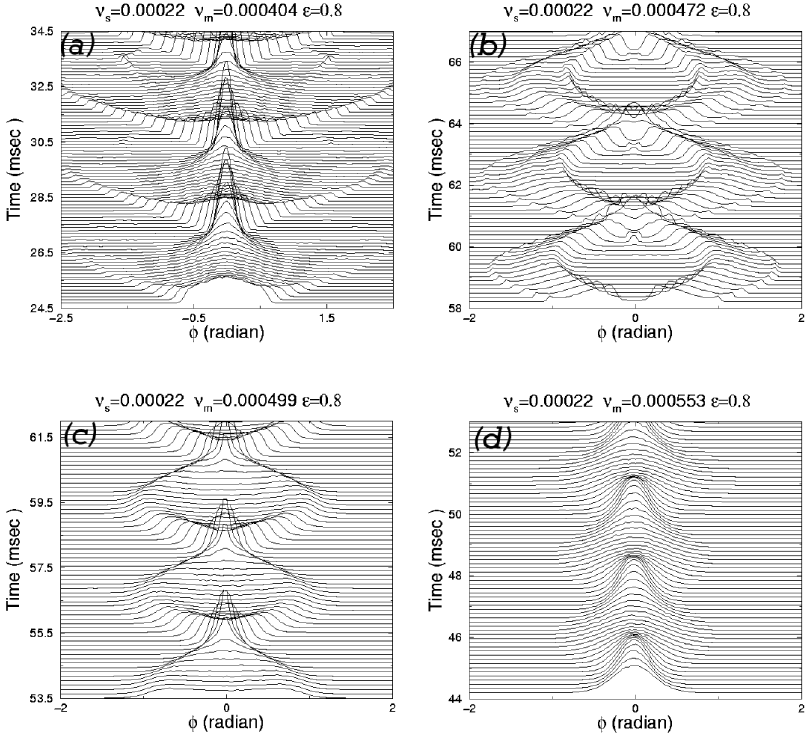
FIG. 6. Simulated mountain range results of tracking 50 000 particles for each of the cases shown in Figs.